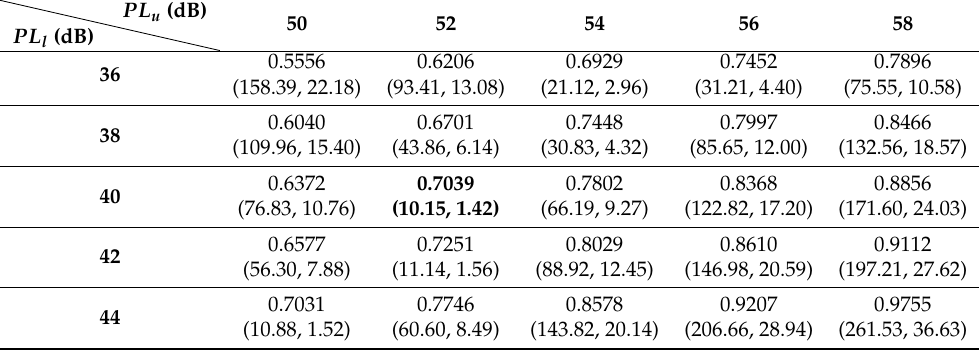
Table 1. Estimation of the step length (m) in the indoor walking scenario for different pairs of upper threshold PL u (dB) and lower threshold PL l (dB). Two values in the brackets of each table cell are the corresponding absolute estimation error (mm) and relative estimation error (%), respectively.